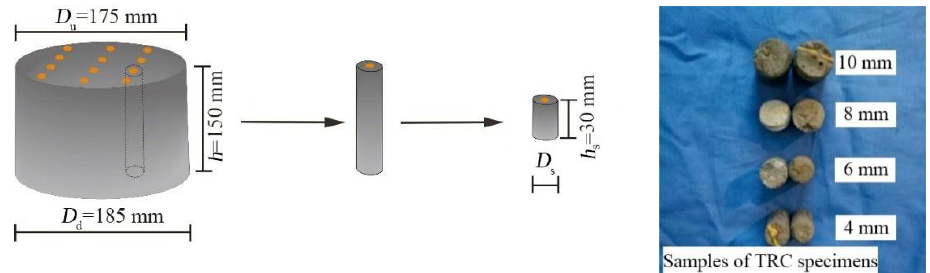
Figure 8. Sampling flow chart.